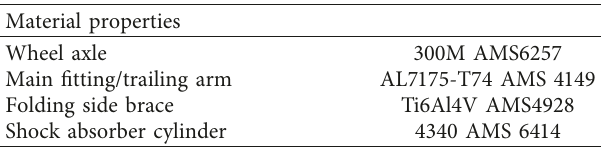
Table 1: Material